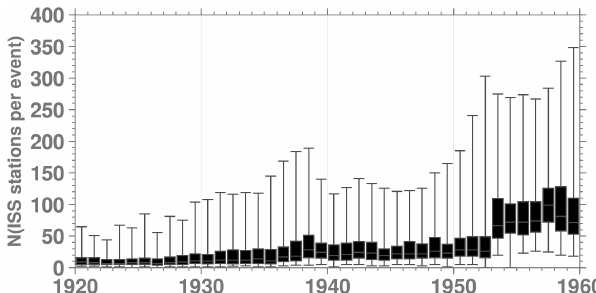
Figure 3. Box-and-whisker plot for the extension events of the me- dian number of ISS stations per event in each year. The box rep- resents the 25%–75% quantile, the band inside the box represents the median and the ends of the whiskers represent the minimum and maximum of all data.